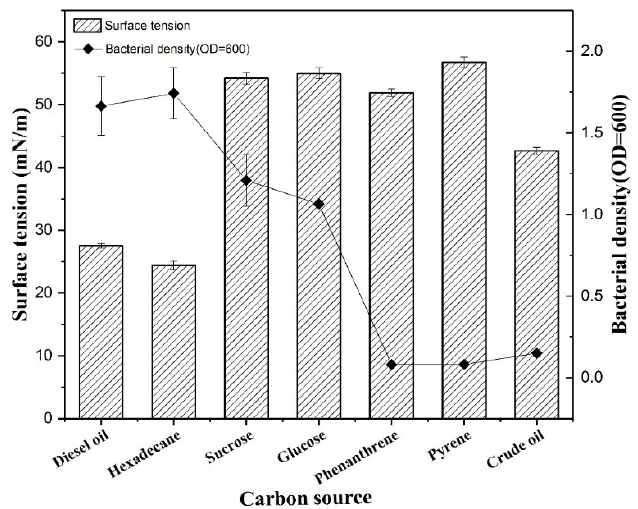
Figure 7. Effect of different carbon sources on surface tension and bacterial density.